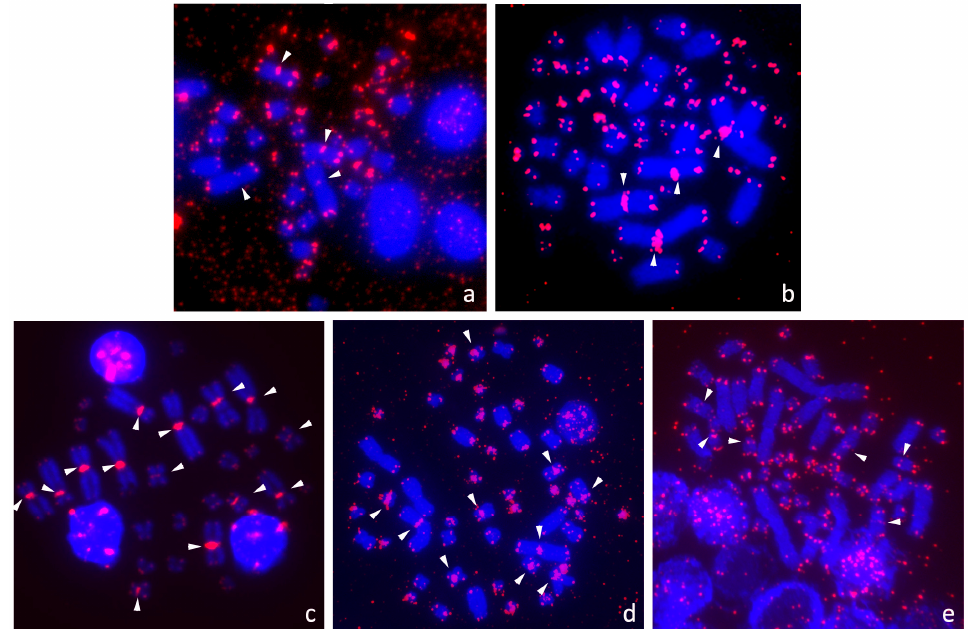
Figure 3. Interstitial telomeric repeats (ITRs) were detected in ( a ) Claudius angustatus , ( b ) Staurotypus salvinii (both Kinosternidae), ( c ) Podocnemis unifilis (Podocnemididae), ( d ) Chelonoidis duncanensis , ( e ) Stigmochelys pardalis (both Testudinidae). White arrows indicate ITRs.